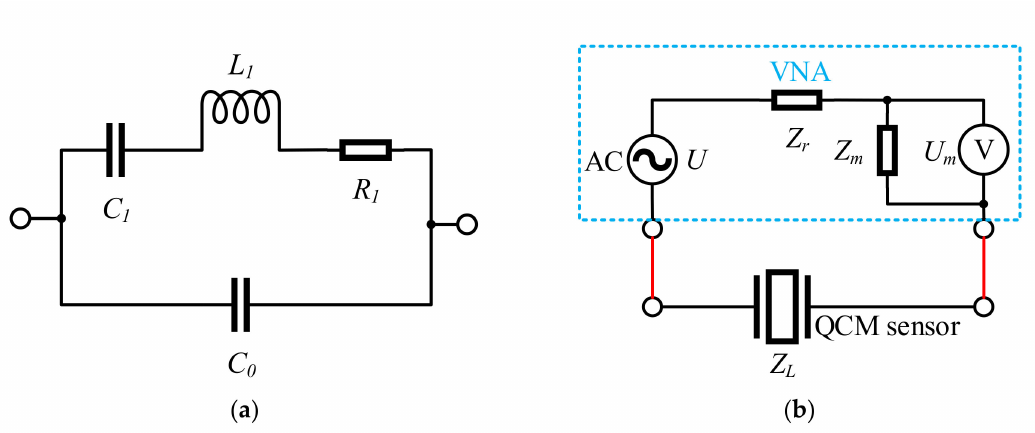
Figure 1. Schematic diagrams of the equivalent circuit of the QCM sensor and the measuring circuit: ( a ) Butterworth–Van Dyke (BVD) equivalent circuit model of the QCM sensor; ( b ) vector network analyzer (VNA) measuring